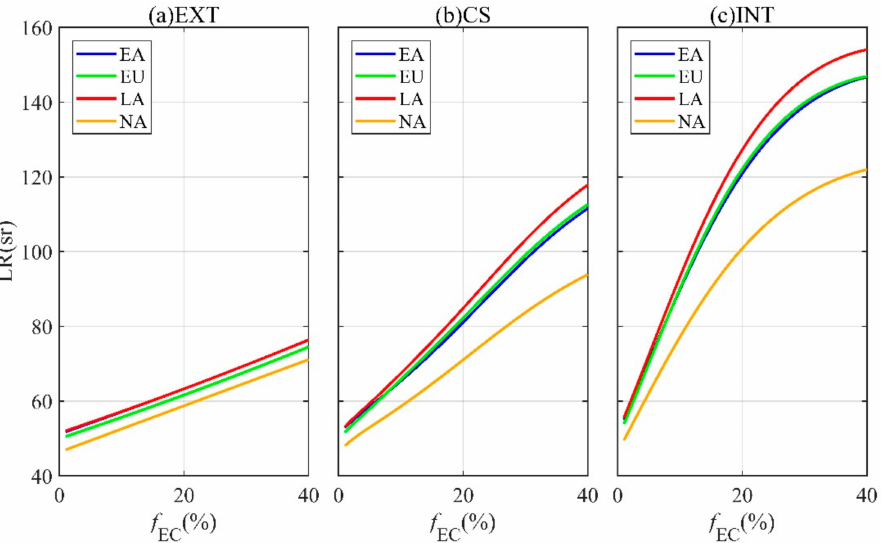
Figure 7. The LR changes with f EC under PNSDs of different regions in ( a ) external mixing state, ( b ) core-shell mixing state, and ( c ) homogeneously internal mixing